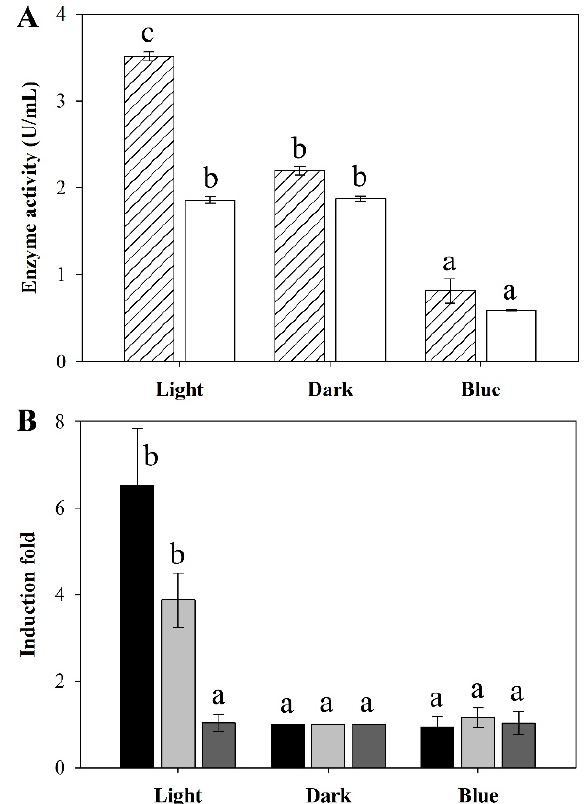
Figure 5. Effect of different wavelengths of light on ( A ) ligninolytic enzyme productions and ( B ) gene expressions in T. polyzona KU-RNW027. MnP ( ) and laccase ( ) activities in the culture supernatant were determined after 7 days of cultivation under different wavelengths of light. Transcriptional levels of the mnp1 ( ), mnp2 ( ), and lac1 ( ) genes were determined using mycelia harvested from the cultures after 7 days of cultivation under different wavelengths of light. Transcription levels of mnp1 , mnp2 , and lac1 are shown as induction fold values relative to those observed under the dark condition. Error bars represent standard deviation ( n = 3). a, b, and c represent significant enzyme production and gene expression compared to the control ( p < 0.05).